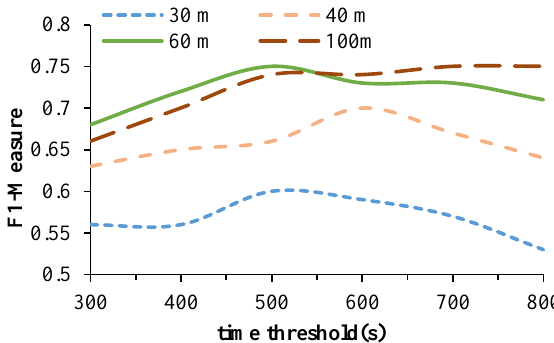
Figure 9. The F1-Measure for different distance and time thresholds.